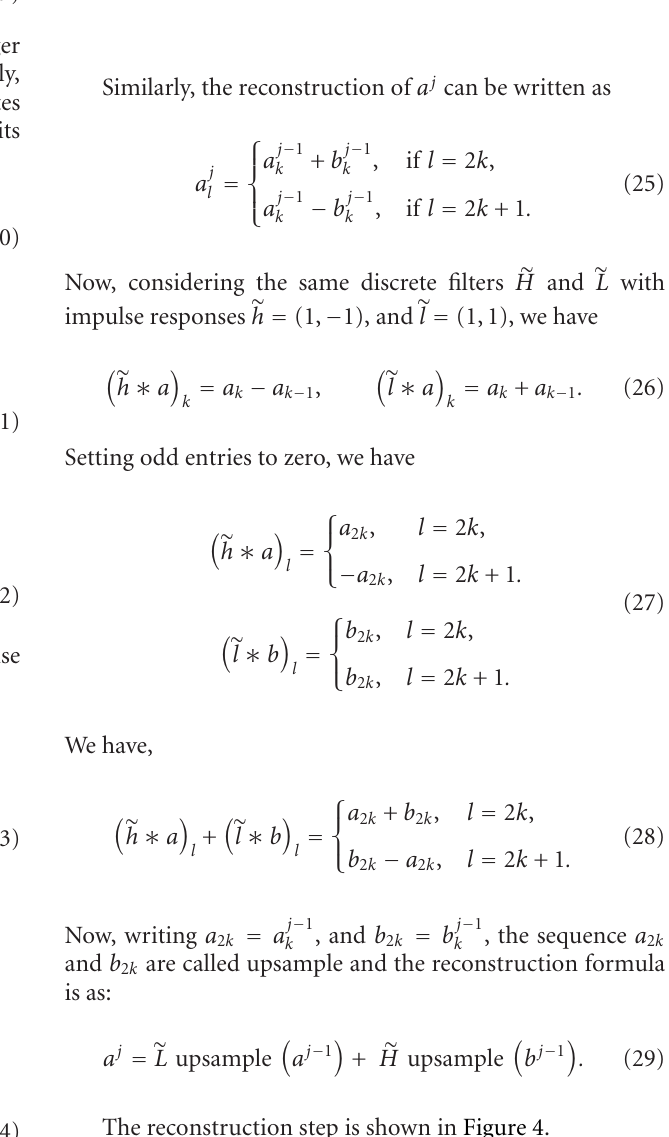
Figure 3: Decomposition of a j with downsampling represented by 2 ↓